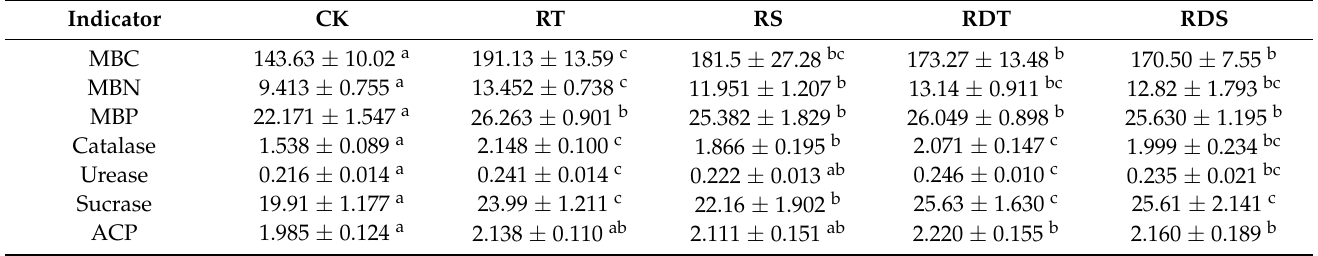
Table 5. Soil biological properties of different residue treatment